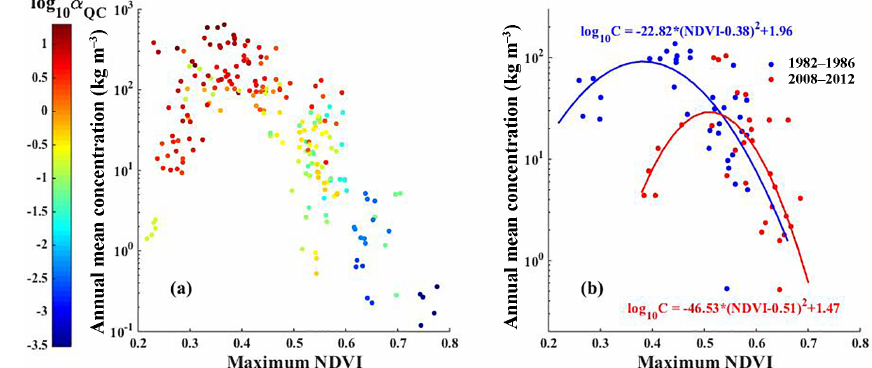
Figure 3. Scatter plot of annual mean concentration and maximum NDVI: (a) at 44 study gauges between 1982 and 1986, where the dots are color-coded by the slope in the Q – C regression ( α QC ) at each gauge; and (b) at seven gauges with both data from the years 1982 to 1986 (blue dots) and the years 2008 to 2012 (red dots). The R 2 for the two fits is 0.6 and 0.44 respectively with a p value < 0 . 001 for both of them.